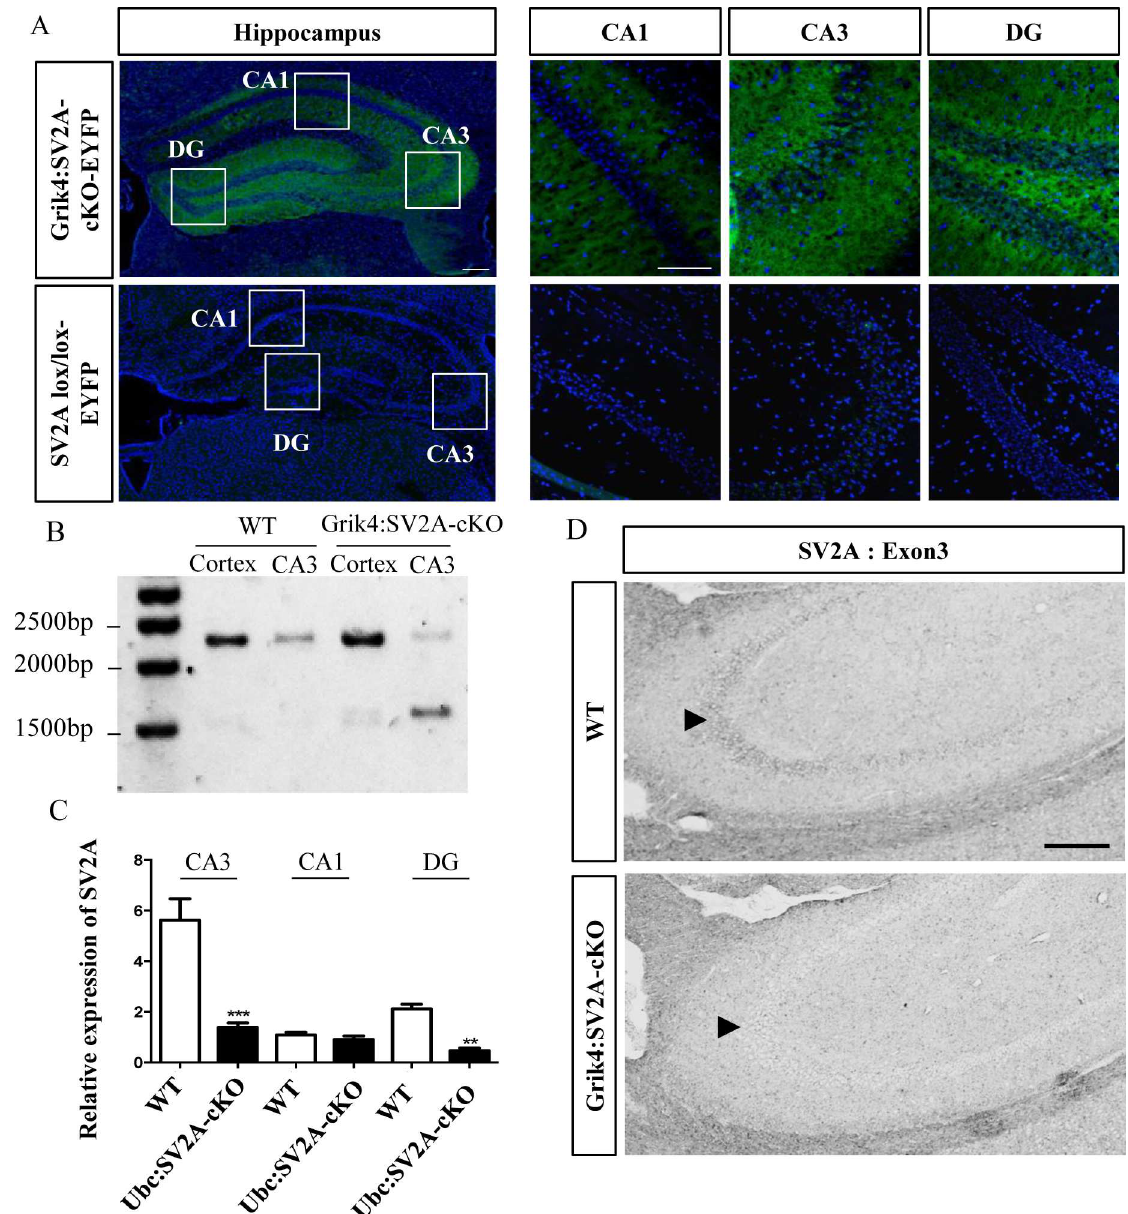
Fig 2. Specific invalidation of SV2A in the CA3 and DG areasof the adult hippocampus. A: Cre-mediatedEYFP reporter expression demonstrating Cre recombination in the CA3andDG areas of the hippocampus of Grik4-CRE/SV2A Lox/Lox /-ROSA-EYFP mice, versuscontrols( i . e .:SV2A lox/lox /ROSA-EYFP) (Green: e-YFP; blue:Hoechst; scalebar = 250 μ m).B: PCR genotypeanalysis on DNA extractedfrom the CA3regionor cerebralcortex andmicrodissected, from WT andGrik4:SV2A-CKO mousebrains(the loxedalleleampliconmigrated at 2,500bpandthe recombined alleleampliconat 1,500bp). C: SV2A mRNAexpressionin the microdissectedhippocampus (CA3, CA1, DG), measured by quantitative real-timePCR, from WT andGrik4:SV2A-cKO mice. The SV2AmRNA levelwas normalizedusingthe GAPDH level. The data is presented as mean ± SEM, ** p < 0.01, *** p < 0.001.D: Conditional removal of SV2A from adultmouseCA3areas,validatedby in situ hybridization usingan LNA probetargetingan exon3 sequenceof the SV2A transcript. The arrowheadindicates the hippocampus. Scale bar = 500 μ